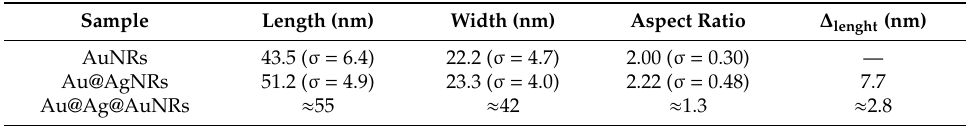
Table 1. Average lengths, widths and aspect ratios obtained from TEM analysis of AuNRs,